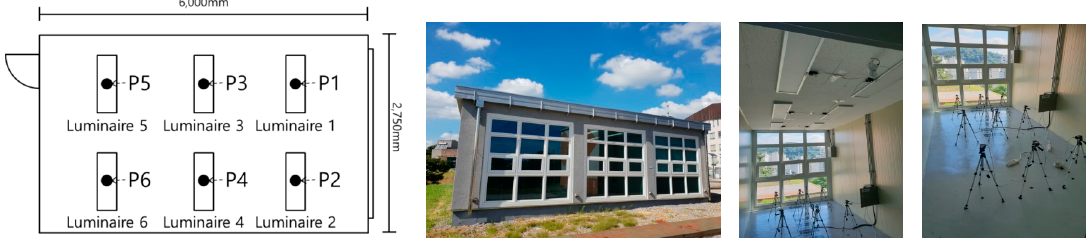
Figure 9. Outline of the full-scale test-bed.